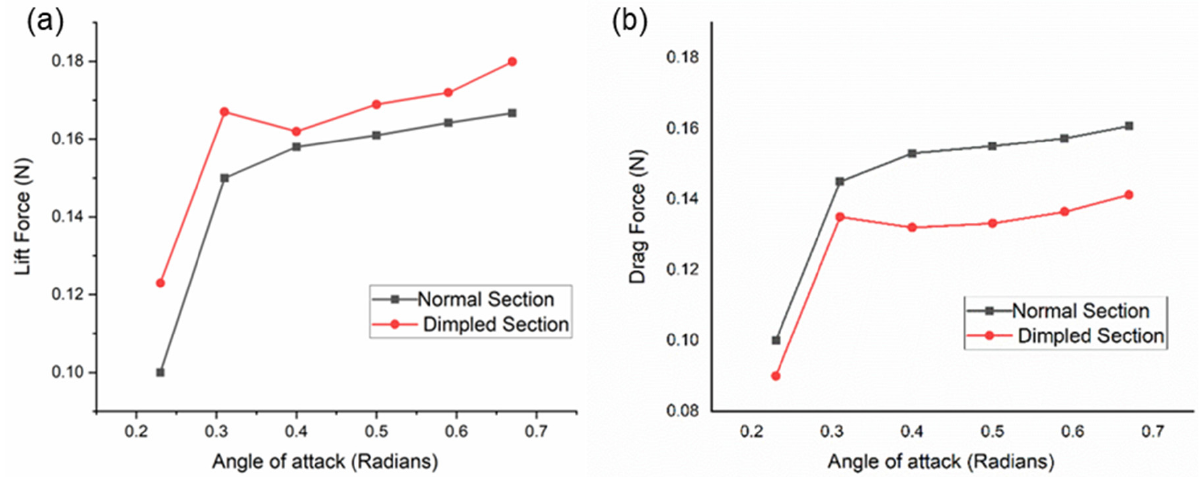
Figure 8. ( a ) Lift and ( b ) drag forces of the normal and dimpled sections with various AOAs. By introducing the dimpled structures on the blade’s surface, the air flows more smoothly along the blade surface, decreasing the wake and creating a low-pressure area behind the wall. As a result, less drag force acts on it. A dimple also reduces the drag. Decreasing the separation point of a fluid on a blade allows a laminar flow to continue longer around the blade’s surface.